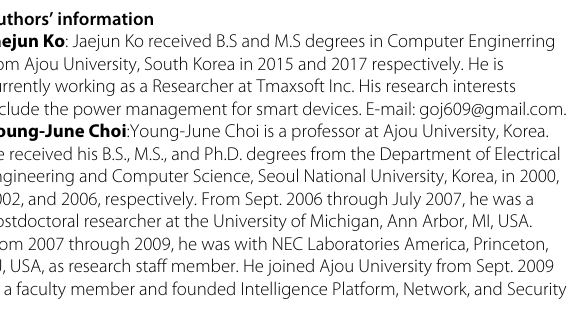
cloud server is low energy consumption on the side of the wearable device. On the smartphone side, it is possi- ble to accommodate requests from wearable devices, but offloading once to the cloud server is energy efficient. When we compared the local energy consumption and the total energy consumption of each smart device from the experimental results, it is evident that offloading a task requested from the wearable device to the cloud server without locally processing is not good in terms of energy efficiency; however, the total energy efficiency is